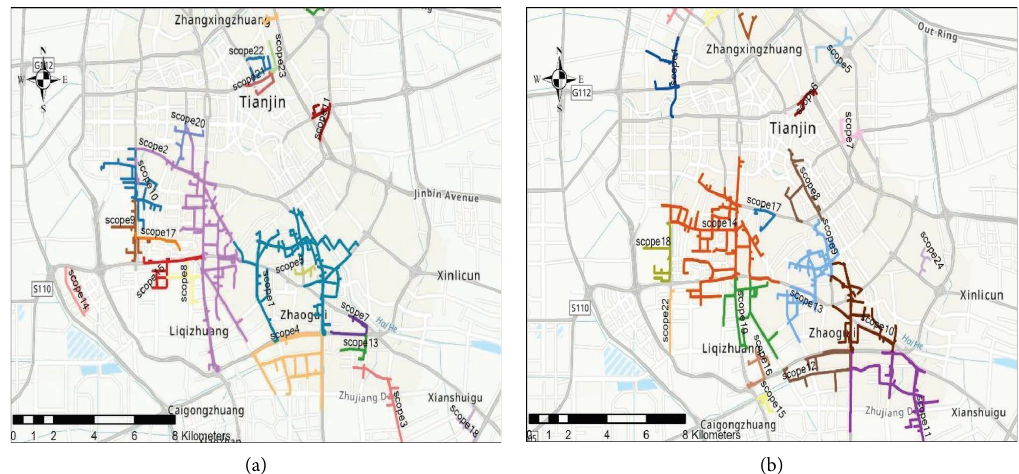
Figure 9: Service scopes of the fexible bus (a) from 8:00 to 8:30 and (b) from 18:00 to 18:30.